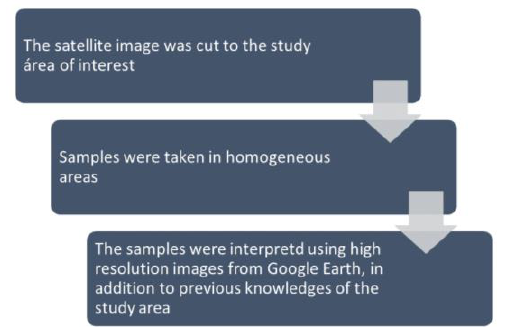
Figure 2: Flowchart of the Landsat satellite image classification process for both the years 1999 and